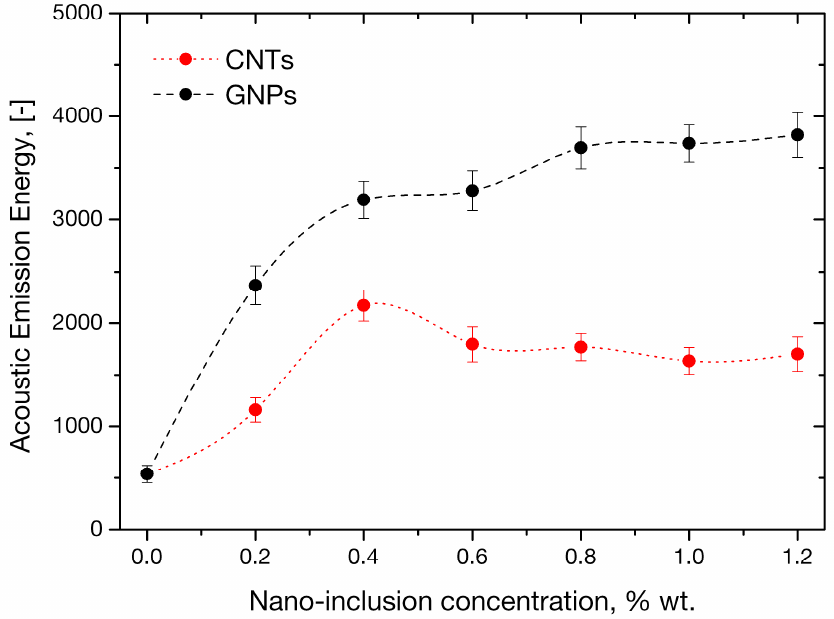
Figure 9. Average AE energy values during flexural testing of mortars with variable nanofiller concentrations.